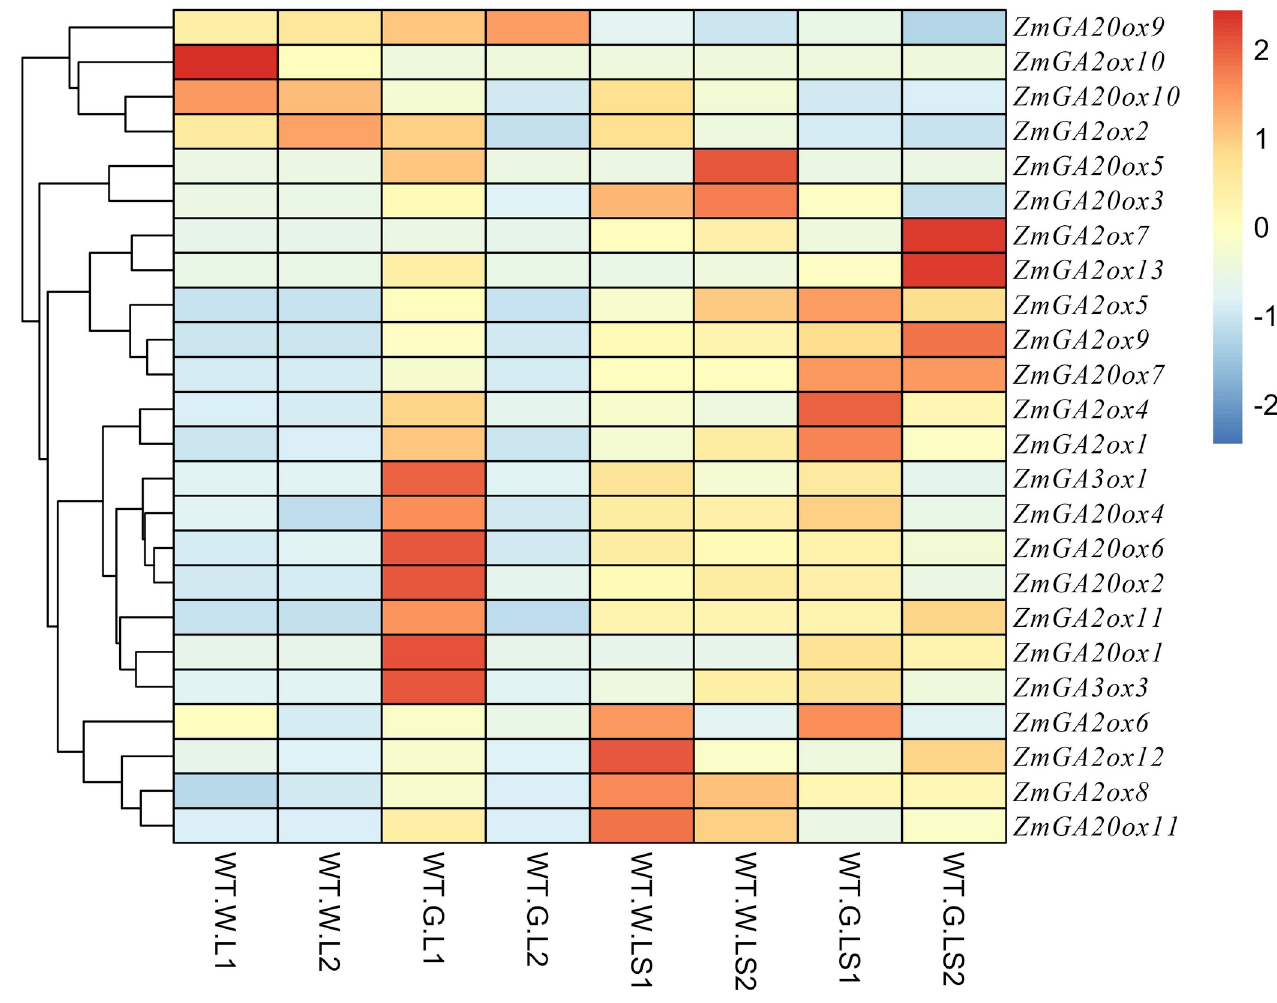
Fig 6. Differential expressed genes in response to